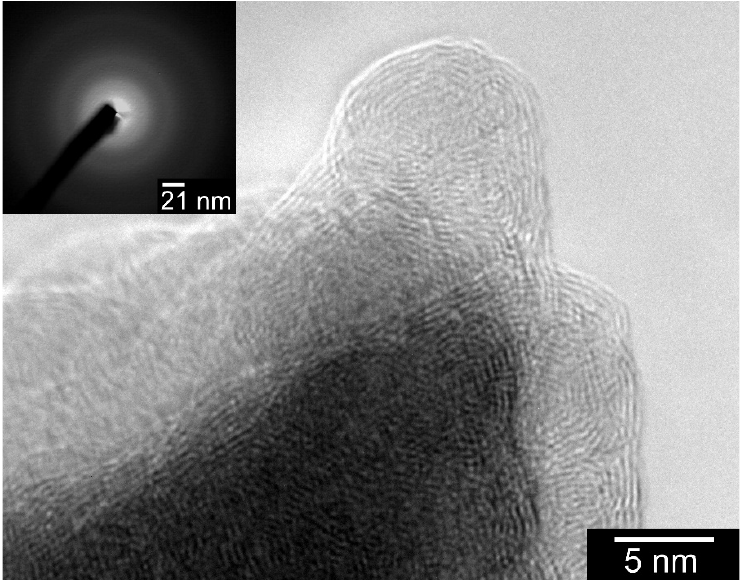
Figure 5. Transmission electron microscopy (TEM) image of V-CB(PANI). The inset panel shows the diffraction pattern of V-CB(PANI) obtained during the TEM observations.